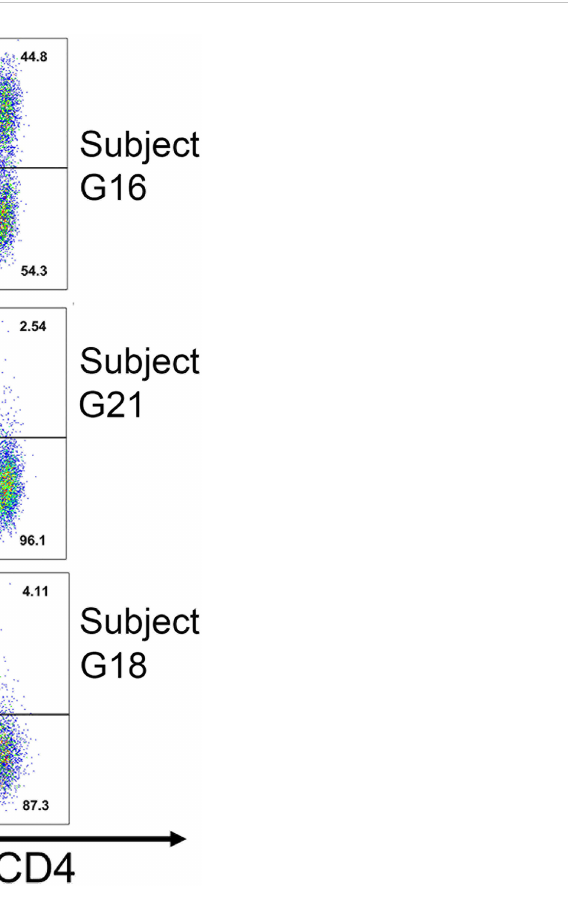
FIGURE 6 Con fi rmation of an HLA-DRB1*0301-restricted FVIII-A2 domain epitope by tetramer staining. T-cell clones expanded by stimulation with 15-mer peptide FVIII-A2-59 (FVIII 605-619) from three unrelated HA subjects: G16 (Int22Inv, current inhibitor), G18 (intron 1 inversion, current inhibitor), and G21 (Int22Inv, no inhibitor history). All three had an HLA-DRB1*0301 allele, and their clones were stained with an HLA-DR0301 tetramer loaded with peptide FVIII-A2-59. The results indicate that this peptide contains an immunodominant, HLA-DRB1*0301 -resticted T-cell epitope recognized by CD4 + T cells from these